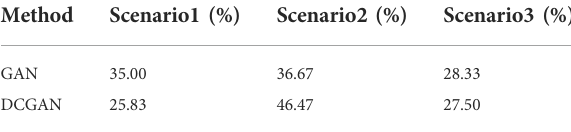
TABLE 4 Probability of occurrence of retained